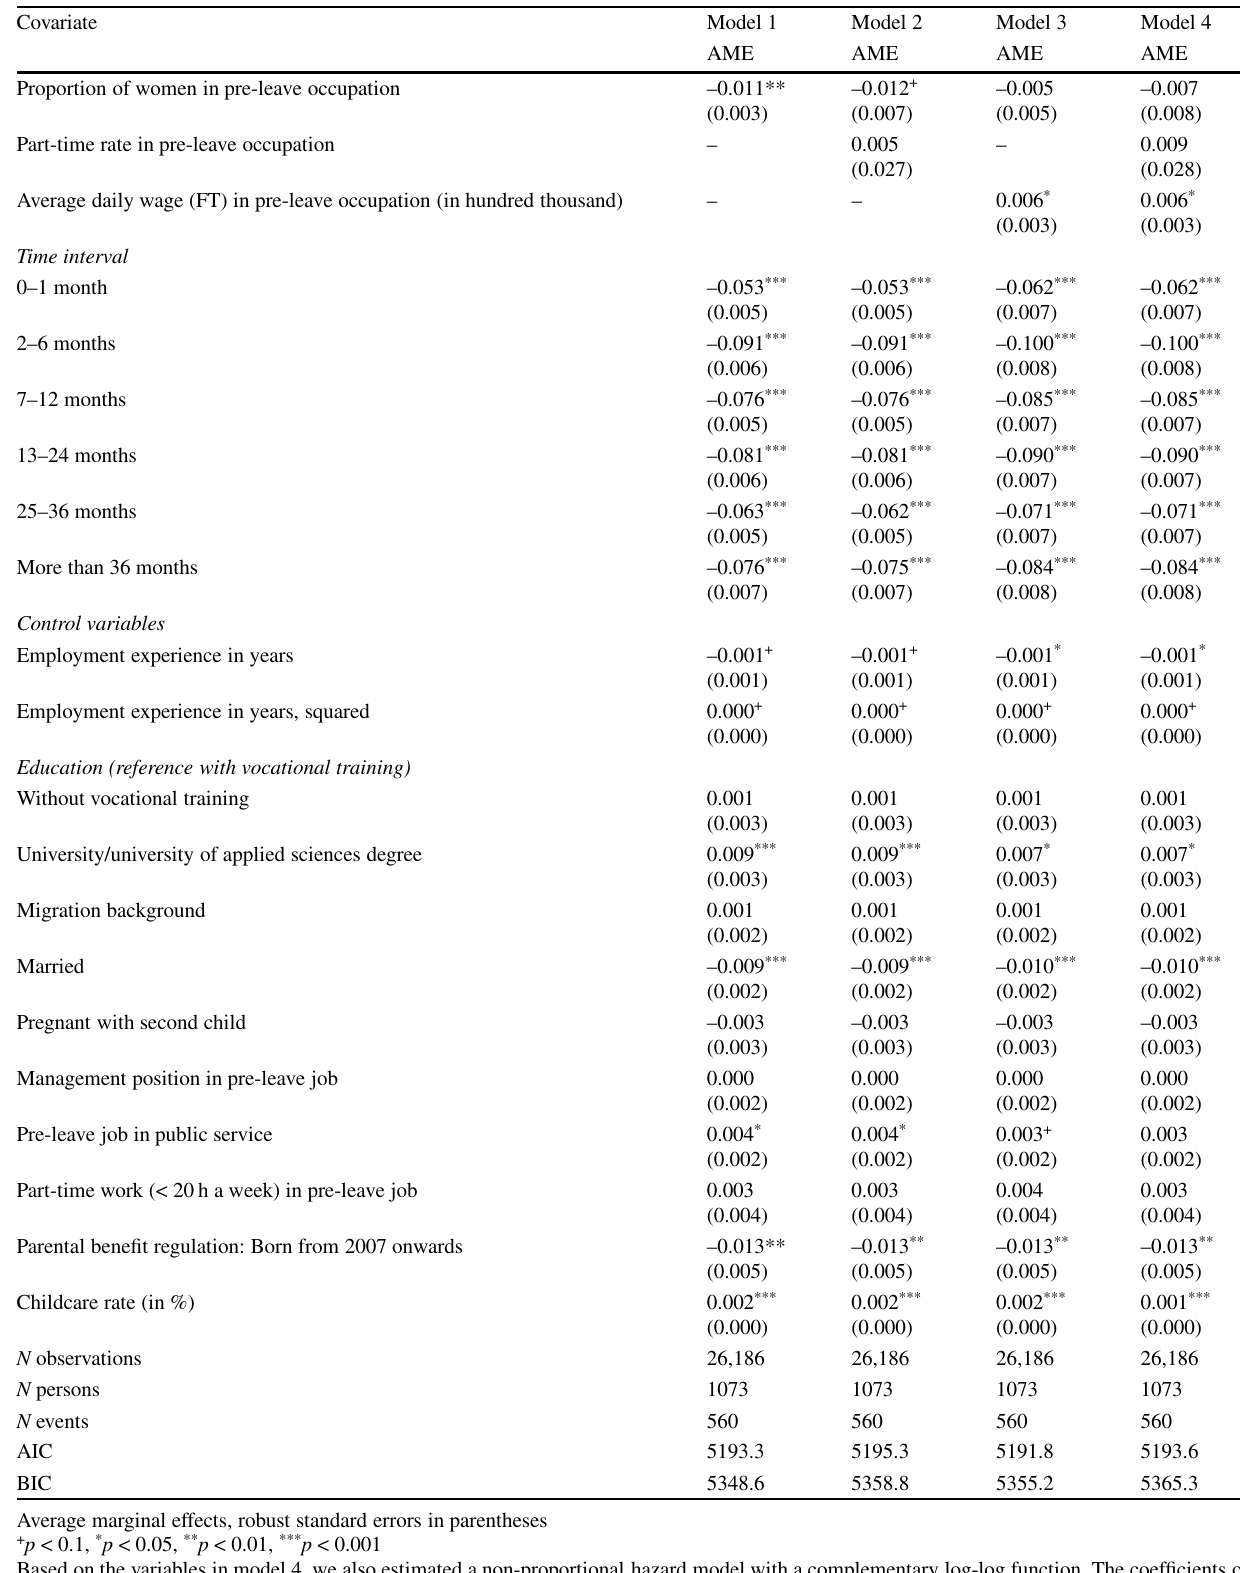
Table 1 Complementary log-log model to estimate the return probability. (Source: NEPS 1.0.0 2011, SIAB weakly anonymous version 7510 & Microcensus, own